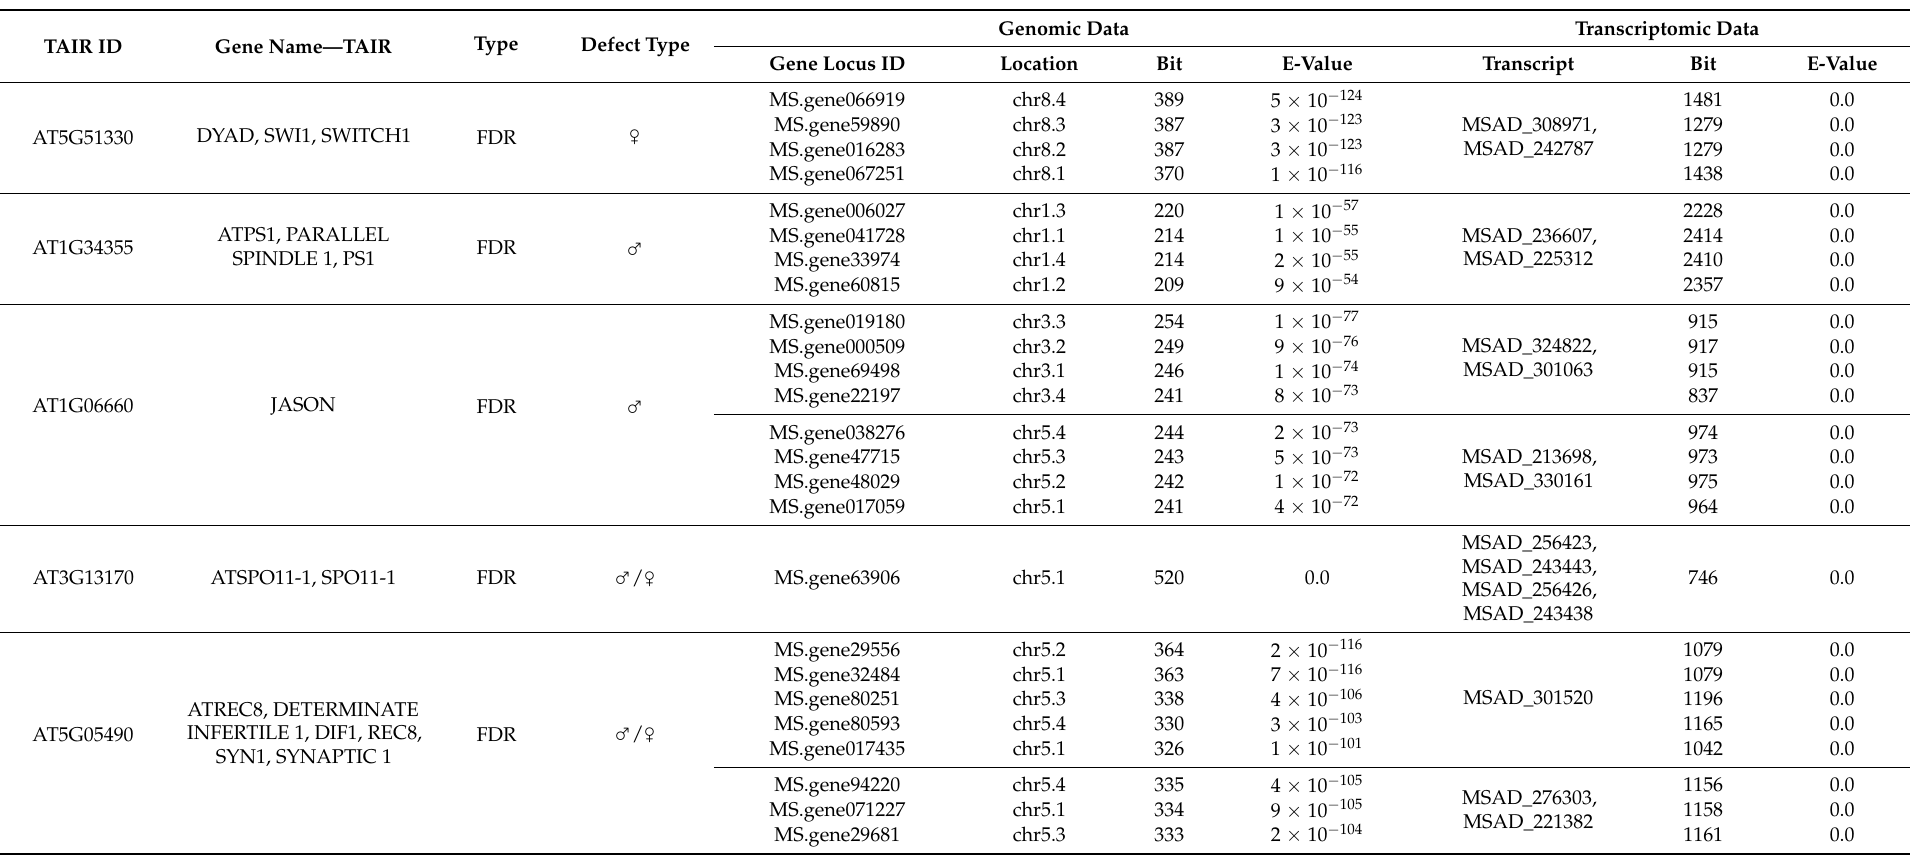
Table 2. Identification of candidate genes involved in unreduced gamete production in M. sativa . Nine proteins belonging to A. thaliana were selected for their direct involvement in unreduced male and/or female gamete production (column defect type) through first division restitution (FDR) or second division restitution (SDR) events. Forty-seven putative orthologs were then retrieved from the alfalfa genome [91] through a BLASTp alignment (chromosome locations of the related genes, Bit scores and E-values are reported). Finally, the corresponding transcripts were then searched through a BLASTp approach (Bit scores and E-values are reported in the last two columns), aligning the 47 proteins against the M. sativa atlas (available from